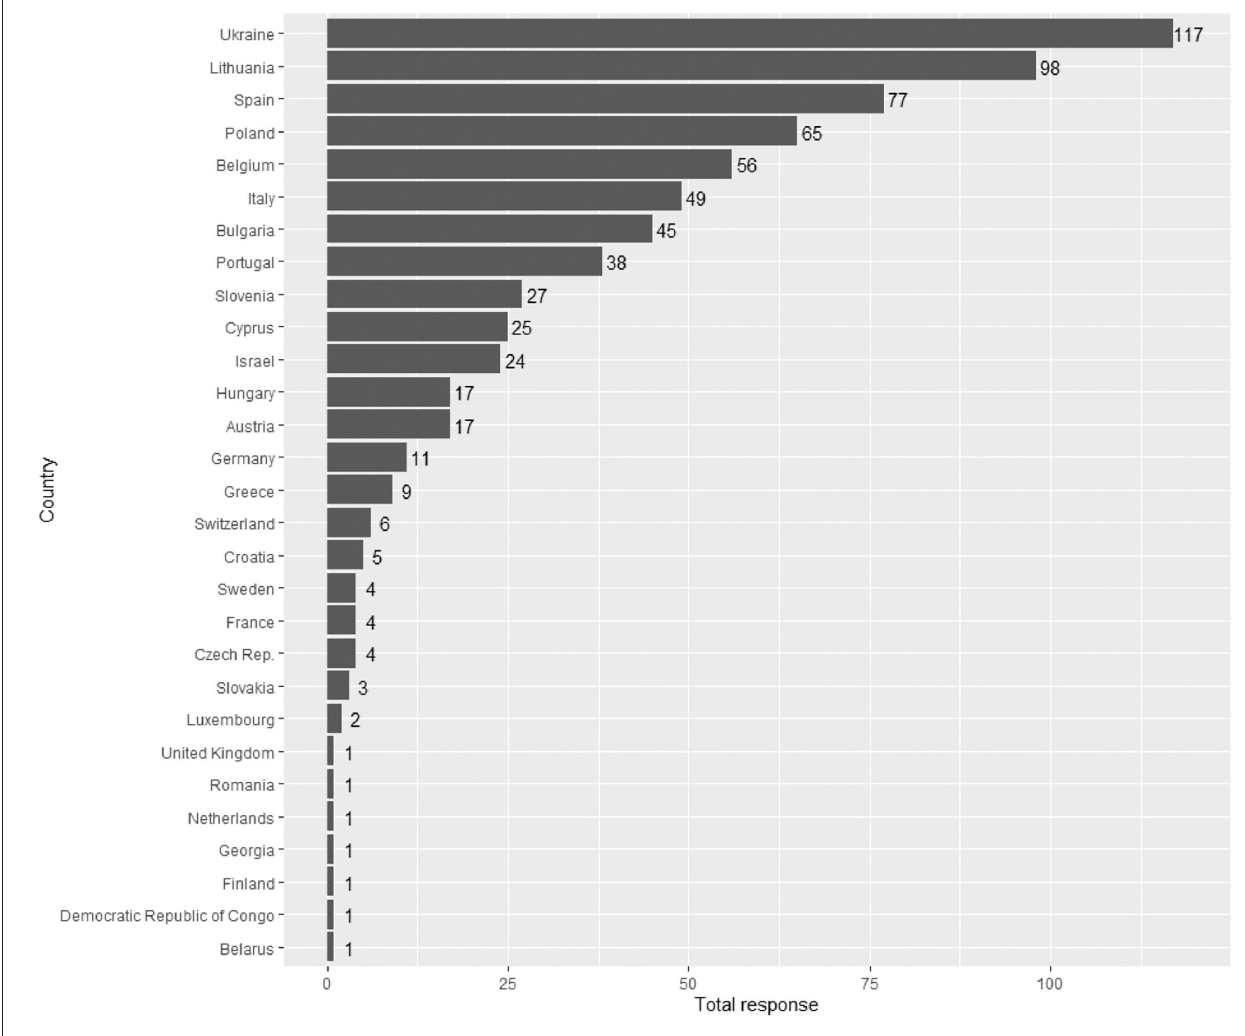
FIGURE 1 | Distribution of participants per